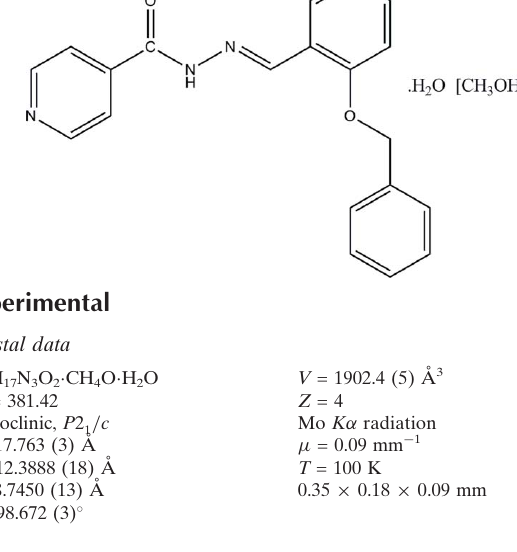
Data collection Bruker APEXII DUO CCD area- detector diffractometer Absorption correction: multi-scan ( SADABS ; Bruker, 2009) T min = 0.968, T max = 0.992 Refinement R [ F 2 > 2 (cid:2) ( F 2 )] = 0.059 wR ( F 2 ) = 0.170 S = 1.00 6515 reflections 270 parameters